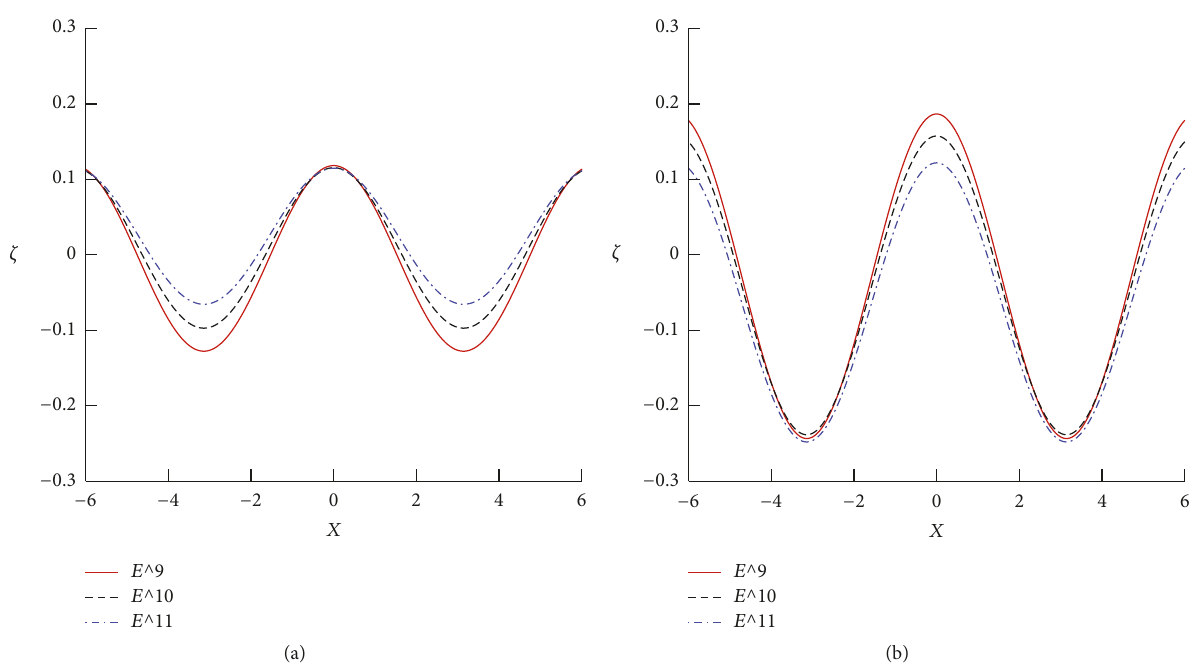
Figure 7: Variation of the hydroelastic wave profiles 𝑥 for different value of Young’s modulus on an opposing current. 𝑈 1,0 = −0.1 . (b) 𝑈 = −0.3 1,0